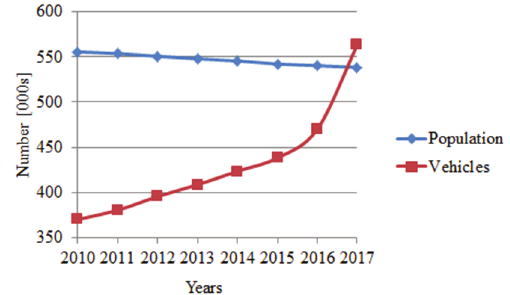
Fig. 1. The number of vehicles registered in Pozna ń in 2017 and the number of inhabitants [6] Motor vehicles usually have 3 or 4 seats for passengers.